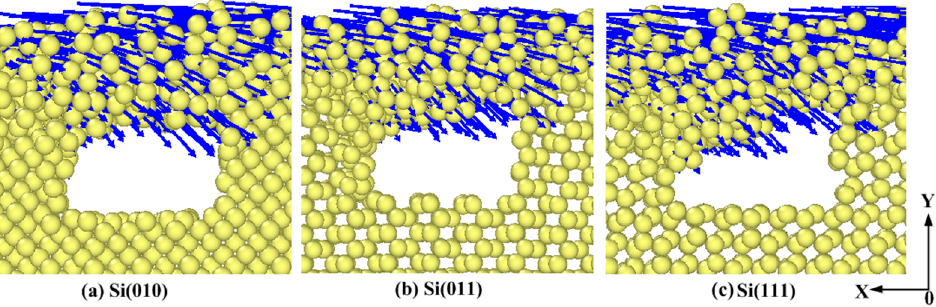
Figure 6. Effects of anisotropy on the deformation of the first pore at the polishing distance of 14.2 nm.